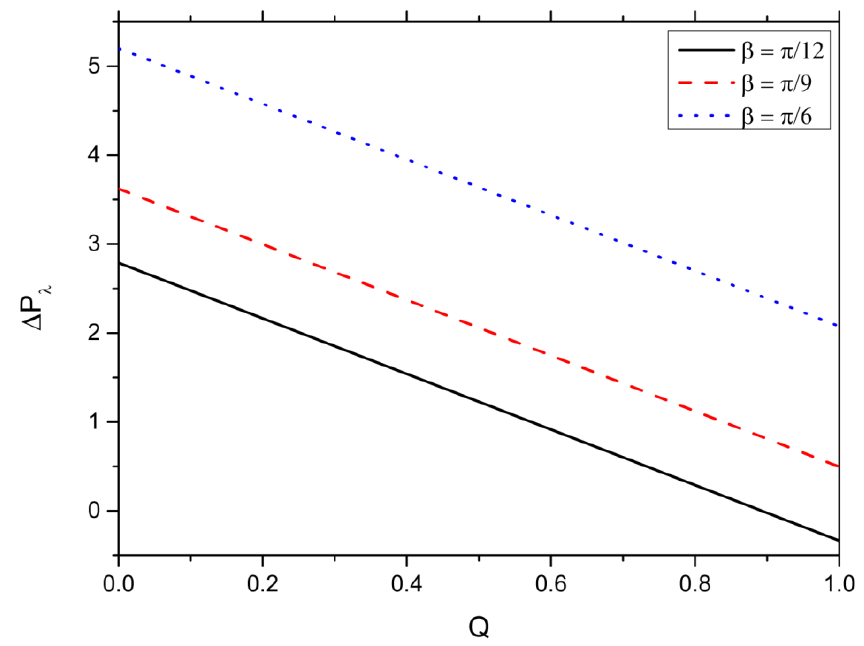
 ) contrary to Q with 